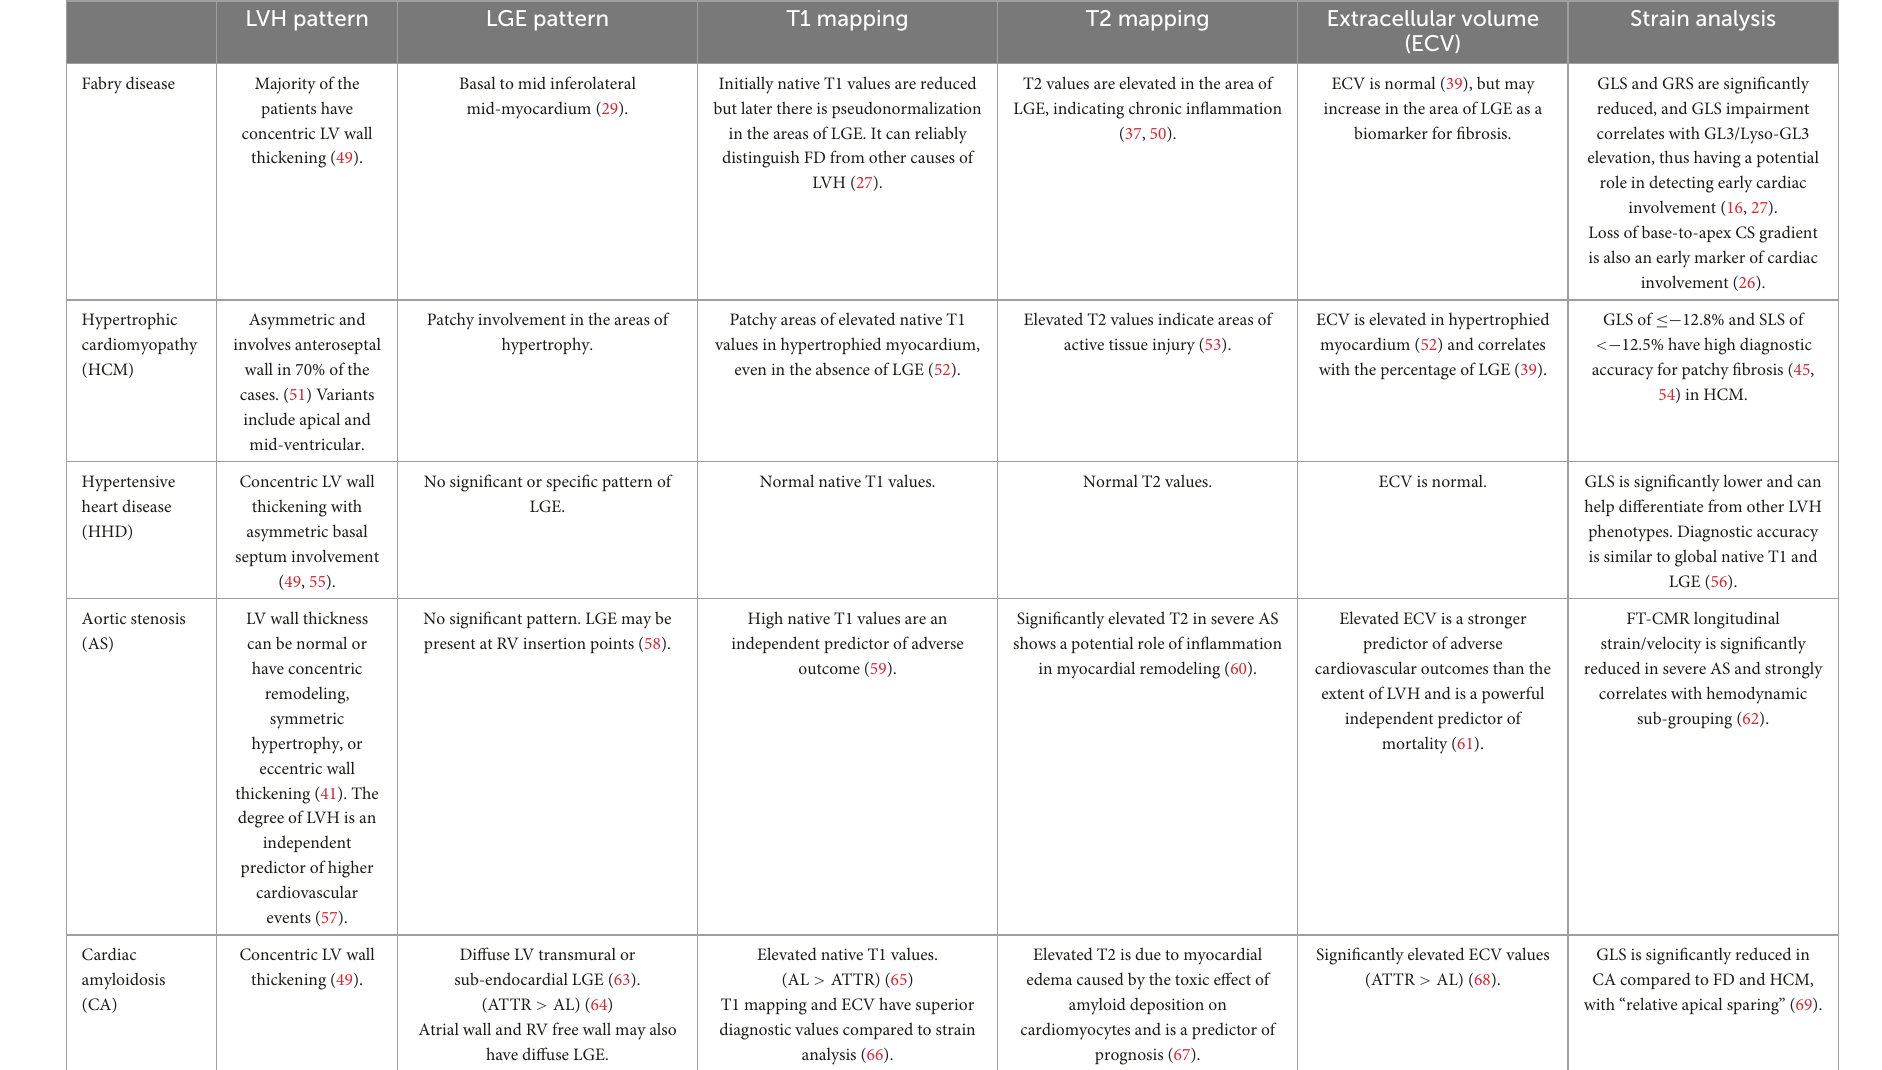
TABLE 1 Role of CMR parameters in characterizing the etiology of hypertrophic cardiomyopathy and the quantitative assessment of treatment efficacy in Fabry disease (FD). LVH pattern LGE pattern T1 mapping T2 mapping Extracellular volume